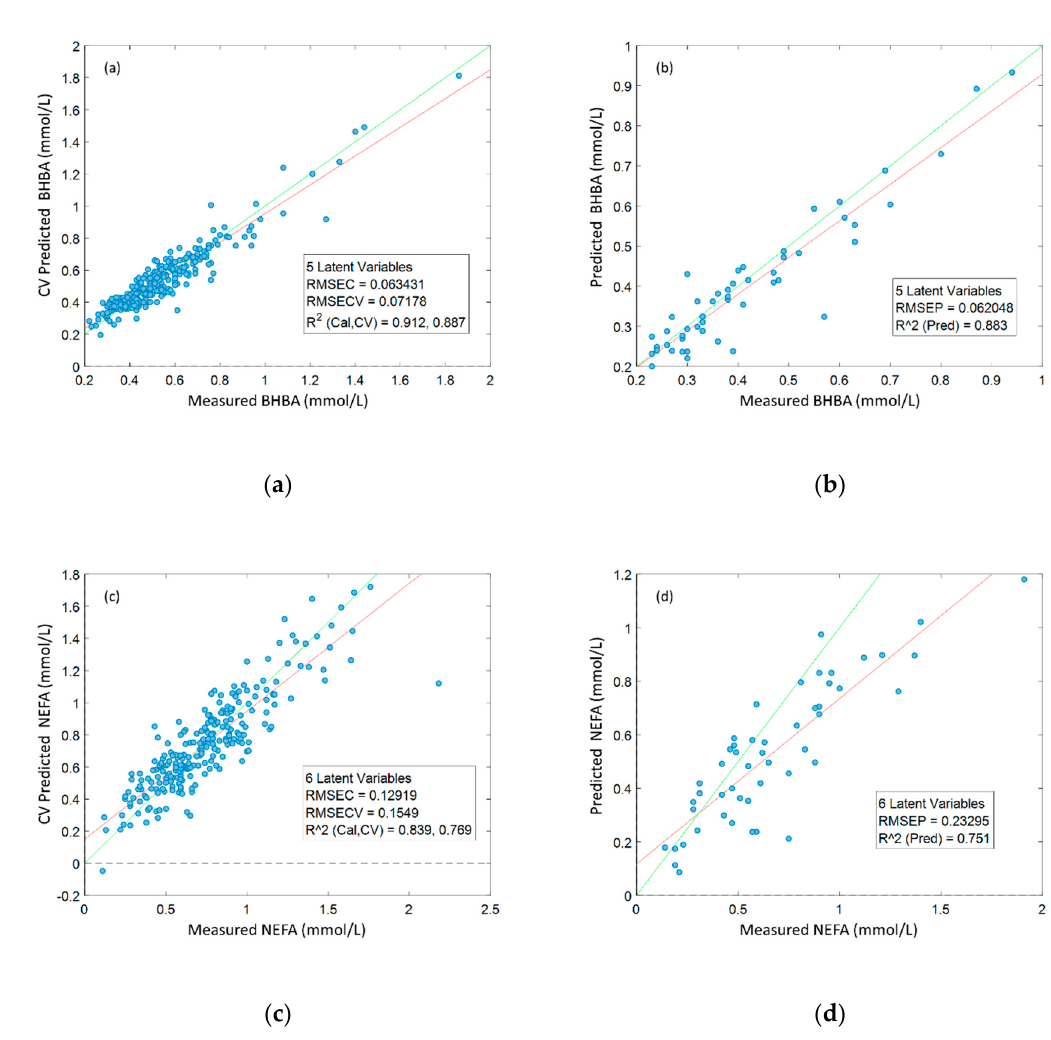
Figure 2. Accuracy of orthogonal partial least squares (OPLS) regression models predicting serum β -hydroxybutyrate (BHBA) and non-esterified fatty acid (NEFA) concentrations from 1 H NMR spectra, built using data from Dataset 1 ( N = 248); ( a ) 10-fold cross-validation (CV)-predicted BHBA vs. measured BHBA; ( b ) external validation ( N = 50)-predicted BHBA vs. actual BHBA; ( c ) CV-predicted NEFA vs. measured NEFA; ( d ) external validation-predicted NEFA vs measured NEFA.